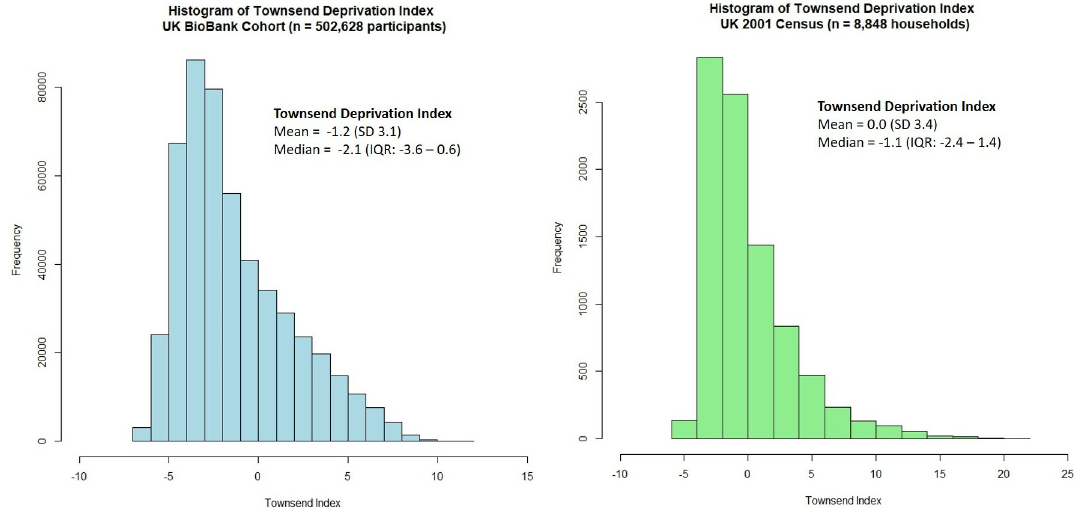
Fig 2. Comparing townsend deprivation index between UK Biobank participants and households in the 2001 UK